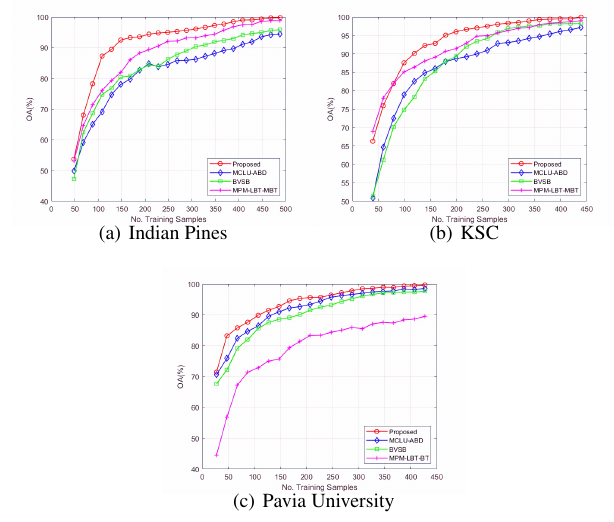
Figure 5. Overall classification accuracy versus the number of training